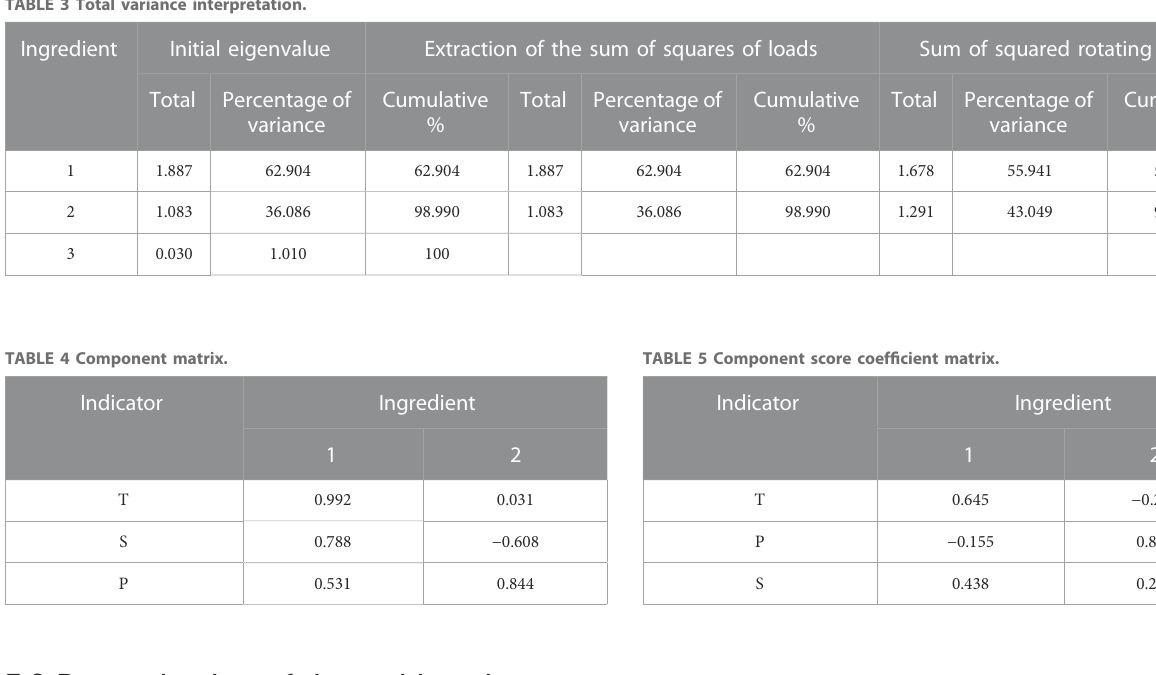
TABLE 3 Total variance interpretation.